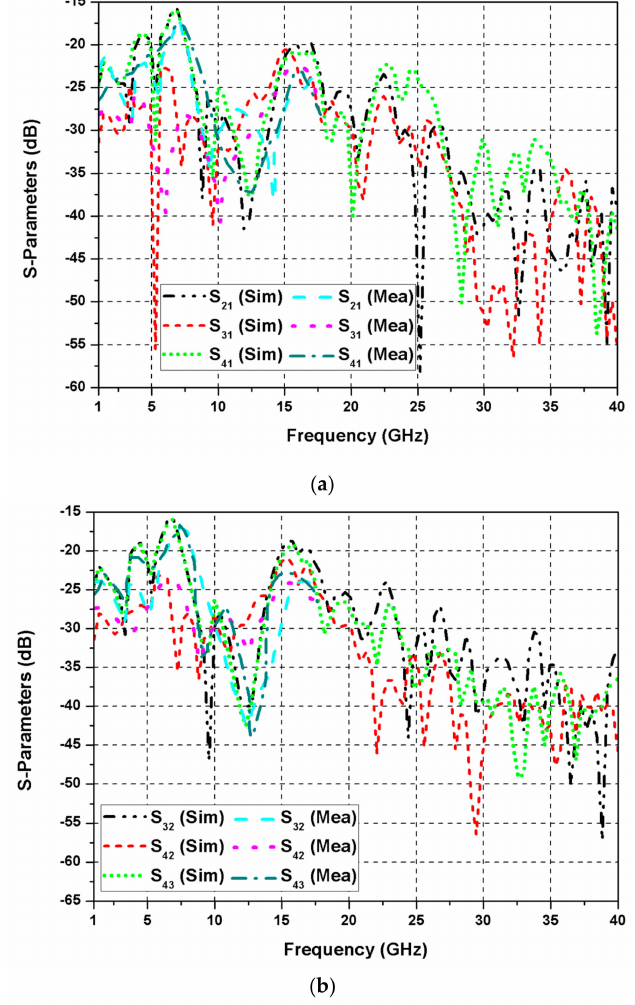
Figure 8. S-parameters of the TSESC MIMO antenna at ( a ) port-1; ( b ) other